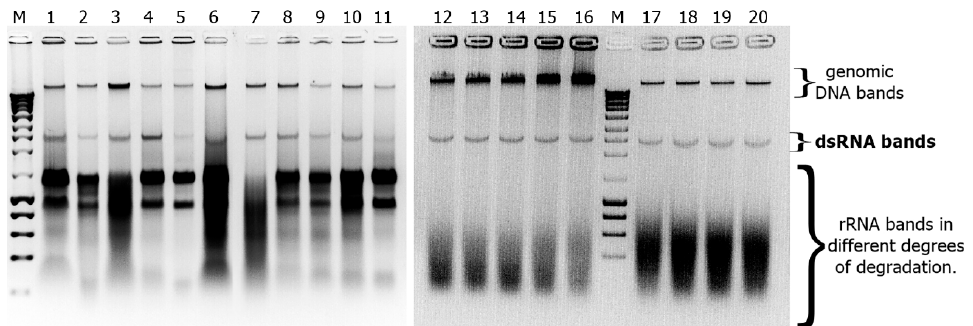
Figure 6. Agarose gel electrophoresis (0.8% w/v in buffer TAE) of chromatography on cellulose extracts prepared from monosporic cultures of mycovirus-infected fungal strains. Lanes 1 through 11: extracts from monosporic cultures prepared from F. andiyazi strain Fa162; lanes 12 through 20: extracts from monosporic cultures prepared from F. verticillioides strain Fv505; Lanes M, 1 Kb DNA molecular weight marker (NZYDNA Ladder III, NZYTech ® , Paço do Lumiar, Lisboa, Portugal).